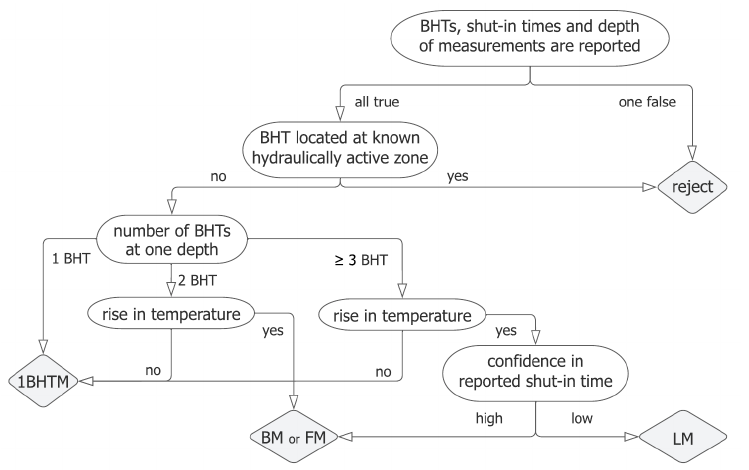
Figure 14. Decision tree for the choice of the BHT correction method dependent on the quality of the available input parameters.